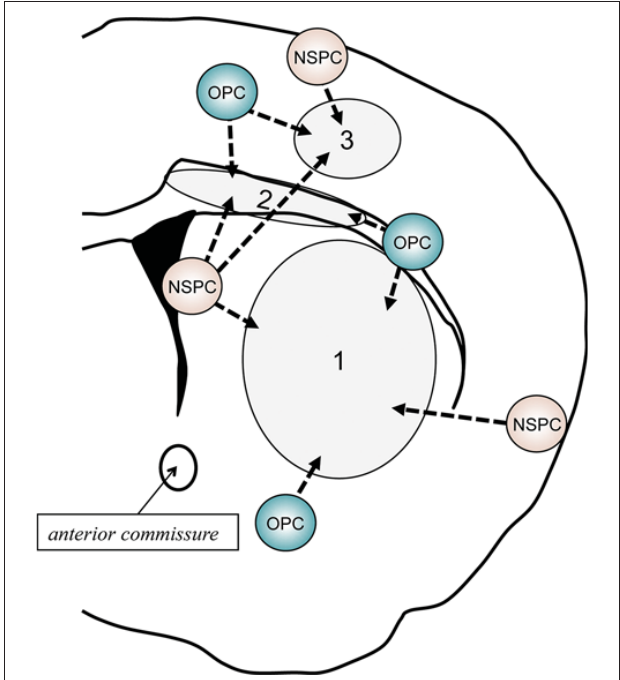
FIGURE 3 | Schematic of behavior of NSPCs and OPCs after demyelination . In response to myelin loss or oligodendrocyte death, both NSPCs and OPCs would attempt to repair the white matter damage by proliferating, migrating to the injured areas, and restoring myelinating oligodendrocytes. If the damaged area is restricted in the corpus callosum (2), V-SVZ-derived NSPCs would shift from neuronal lineage cells to oligodendroglial lineage cells. In addition, residing OPCs adjacent to the damaged area may also contribute to the repairing. Although the V-SVZ-derived NSPCs could travel to the cortex (1) or striatum (3), the recruitment of local OPCs/NSPCs outside of the V-SVZ (e.g., pia matter and/or cortical layer 1) to the lesion area would be more important when the demyelination occur in these areas.